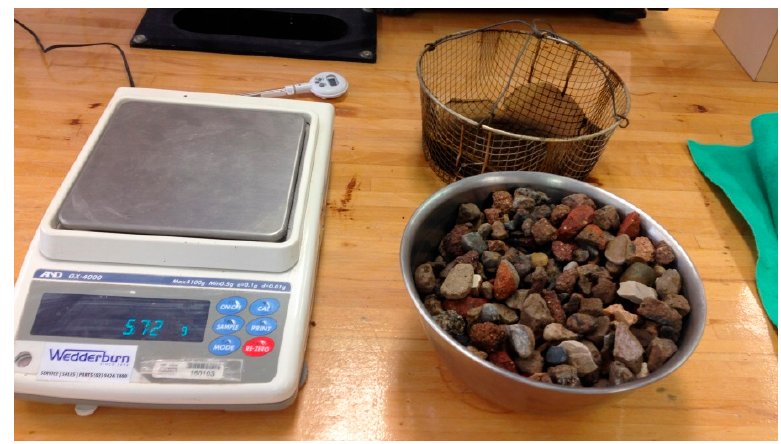
Figure 6. Evaluation of Particle Density of Coarse Aggregate. Table 4. The Results of Particle Density and Water Absorption Test on Coarse Aggregates and Water Absorption Limits for Dense Graded Asphalt Based on Australian